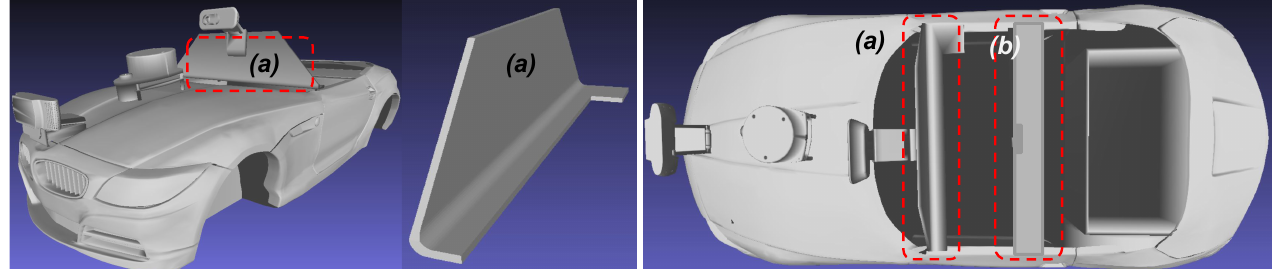
Figure 4. The rigid acrylic fixtures. ( a ) The replacement of the original windshield of the car. It holds sensors as well as the motor control box. ( b ) The laptop computer holder. The original seat was removed, and a rigid acrylic board was affixed to have a stable position for the laptop computer.